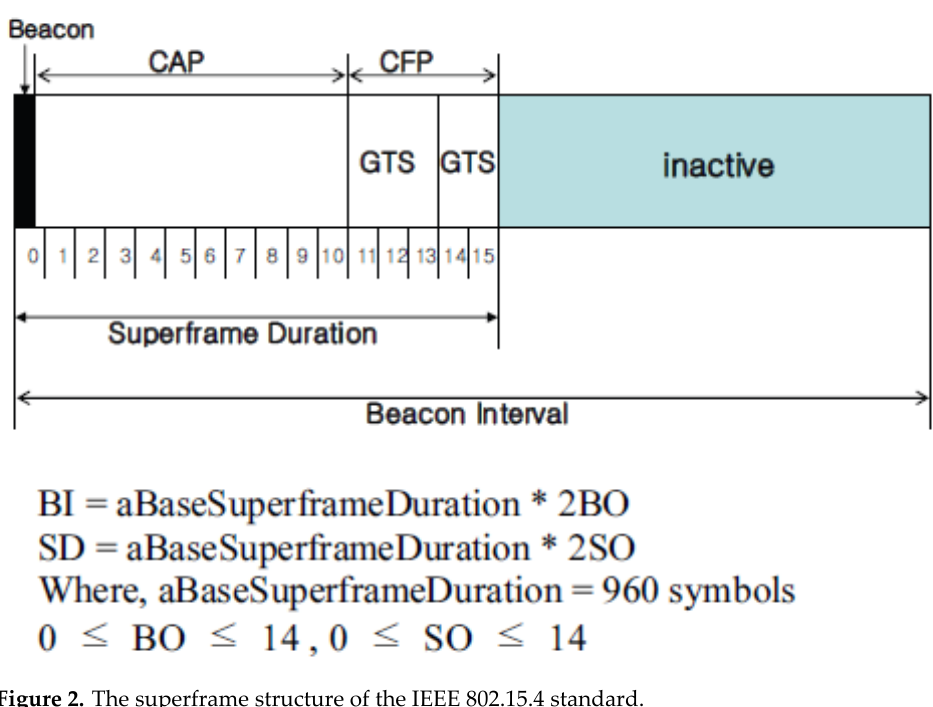
Figure 2. The superframe structure of the IEEE 802.15.4